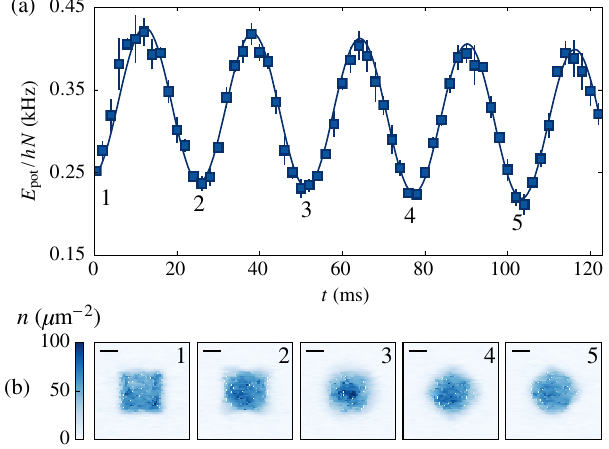
FIG. 1. Time evolution of the potential energyper particle of a 2D gas of 87 Rb atoms in an isotropic harmonic potential offrequency ω for a square of side length 27 . 6 ð 5 Þ μ m with 4 . 1 ð 2 Þ × 10 4 atoms. (a) Evolution of the potential energy per particle. Each point is an average of seven to ten realizations, and the error bars indicate the standard deviation of these different realizations. The frequency of the trap is measured with the oscillation of the center of mass: ω = 2 π ¼ 19 . 3 ð 1 Þ Hz.Theoscillationsof E arefittedwithacosine pot function and an additional linear slope (continuous line). This slope is − 0 . 25 ð 4 Þ Hz = ms and accounts for the loss of particles from the trap. The fitted frequency is 38.5(1) Hz, which is compatible with ω = π , as predicted by the SO(2,1) symmetry of the gas. (b) Density distribution of an initially uniform gas after the evolution in a harmonic potential at times ω t ¼ 0 , π , 2 π , 3 π , 4 π , corresponding to thefirstperiodsofthepotentialenergyindicatedbythelabelsfrom1 to 5. The horizontal black lines represent 10 μ